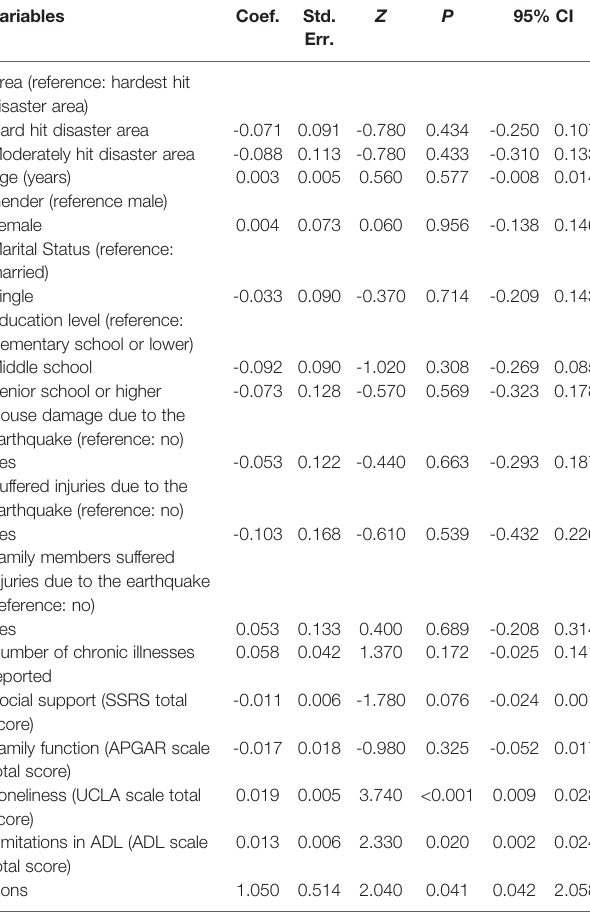
TABLE 5 | Univariate analysis of the association of the severity of depressive TABLE 6 | Results of the generalized linear model for the association of symptoms (GDS-15 total score) with potential risk factors (n = 962). depressive symptom severity (GDS-15 total score) with potential risk factors (n = 962). Categorical variables 1st Median quartile